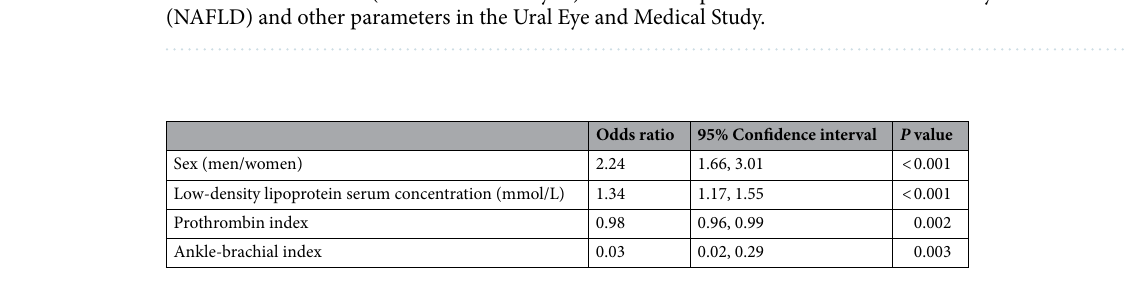
Table 3. Associations (multivariable analysis) between the prevalence of non-alcoholic fatty liver disease (NAFLD) and other parameters in the Ural Very Old